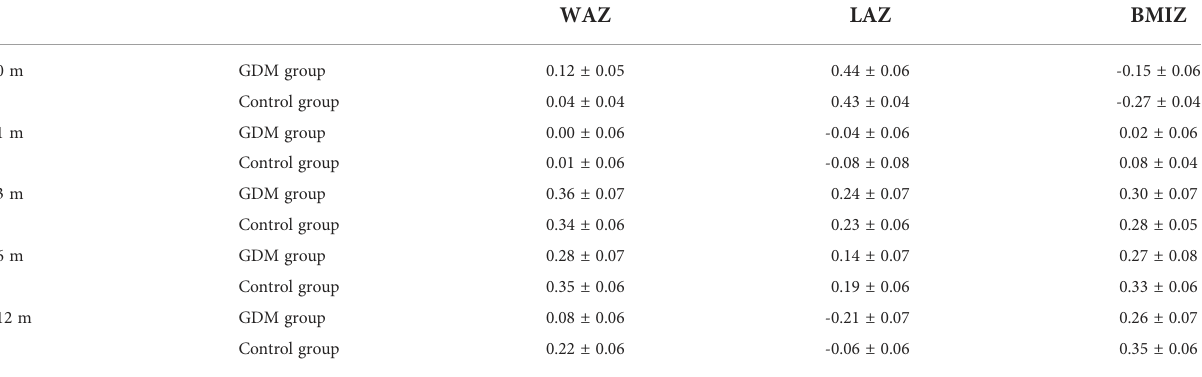
TABLE 3 Outcomes of Z scores in the two groups at different ages ( (cid:1) X SE ).